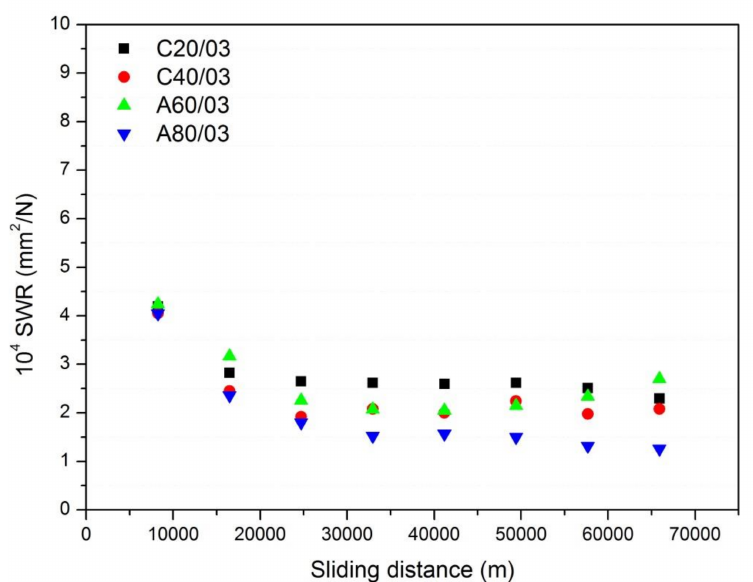
Figure 6. Evolution of SWR in the element pads containing ELT rubber particles of different sizes with the friction